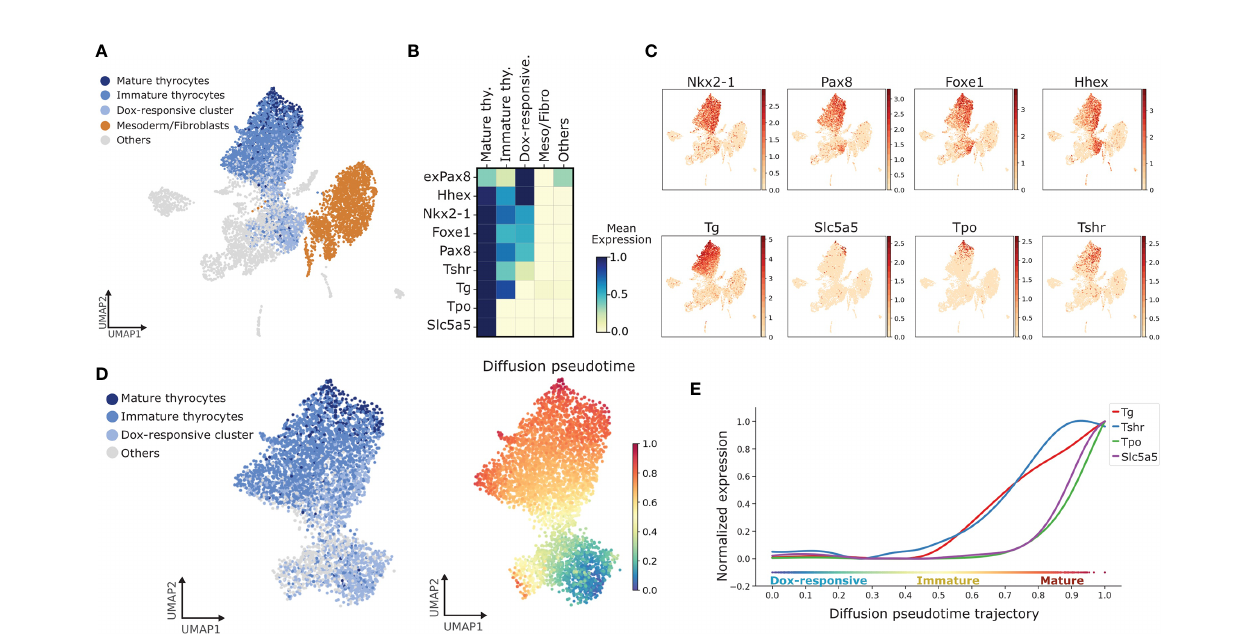
FIGURE 3 | Identi fi cation of pathways dynamically regulated during TFCs maturation. (A) UMAP displaying subclusters within the thyroid lineage (Dox-responsive cluster, immature and mature thyrocytes). Remaining cells are labeled as ‘ Others ’ . (B) Gene-expression matrix plot for thyroid markers: exPax8 , Hhex , Nkx2-1 , Foxe1 , Pax8 , Tshr , Tg , Tpo , Nis / Slc5a5 in subclusters of thyroid lineage and other cell groups. Color intensity in each square represents mean expression in the corresponding cluster. (C) UMAP overlaid with gene expression plots for thyrocyte markers. Color indicates normalized expression. (D) Diffusion pseudotime analysis of thyrocyte lineage. (Left) UMAP displaying the subclusters within the thyroid lineage; (Right) UMAP overlaid with pseudotime. Color in the pseudotime plot indicates the ordering of the cells. (E) Expression trends of thyroid differentiation markers along pseudotime